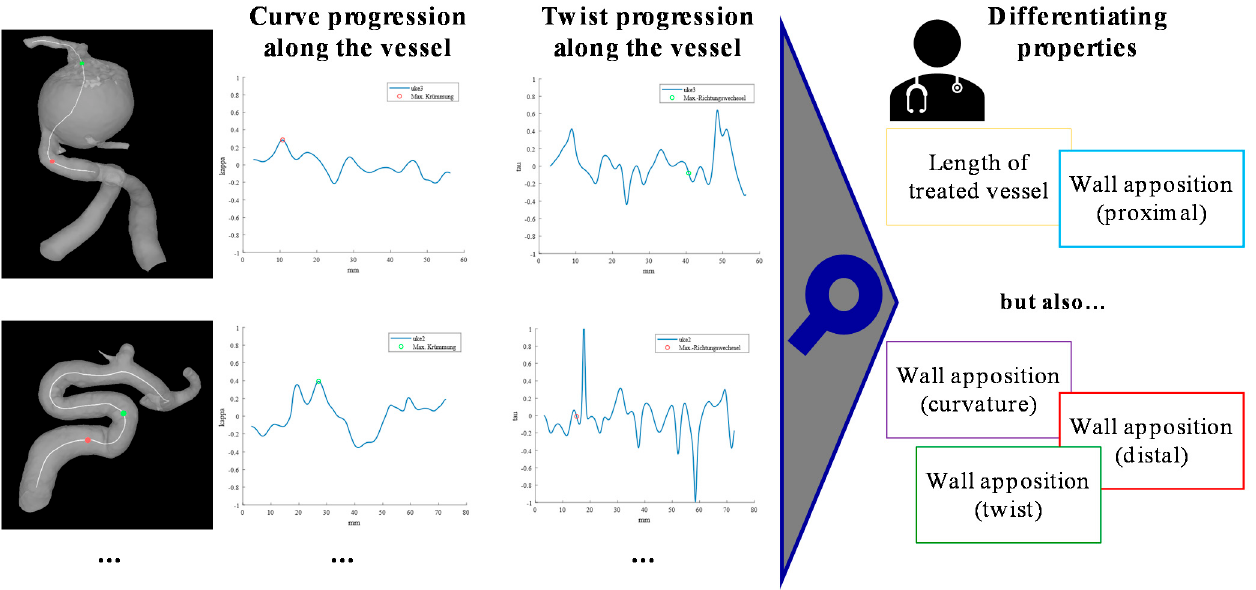
Figure 7. Verification and enhancement of differentiating properties relevant for the customer.